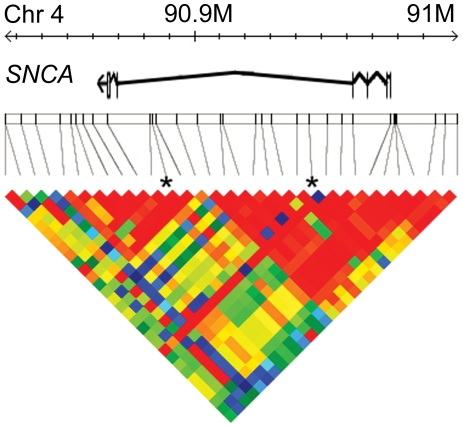
The genetic architecture of the SNCA gene and the markers genotyped.The base pair position along chromosome 4 is shown by the top ruler. The position of the α-synuclein gene is shown in the next row down, with exons represented by vertical lines and introns by lines connecting them. The relative positions of the genotyped markers are shown below, with vertical lines connecting position to the linkage disequilibrium map. Asterisks show the two markers demonstrating association in MSA-C. Only the left-most marker showed association with MSA as a whole. (For a list of markers genotyped and P-values, see Table 3). The coloured triangle is the linkage disequilibrium heat map showing the strength of association between pairs of markers as measured by D′. Red is high and blue low with the other colours intermediate. The two associated SNPs are in different linkage disequilibrium blocks and are not in linkage disequilibrium with each other.